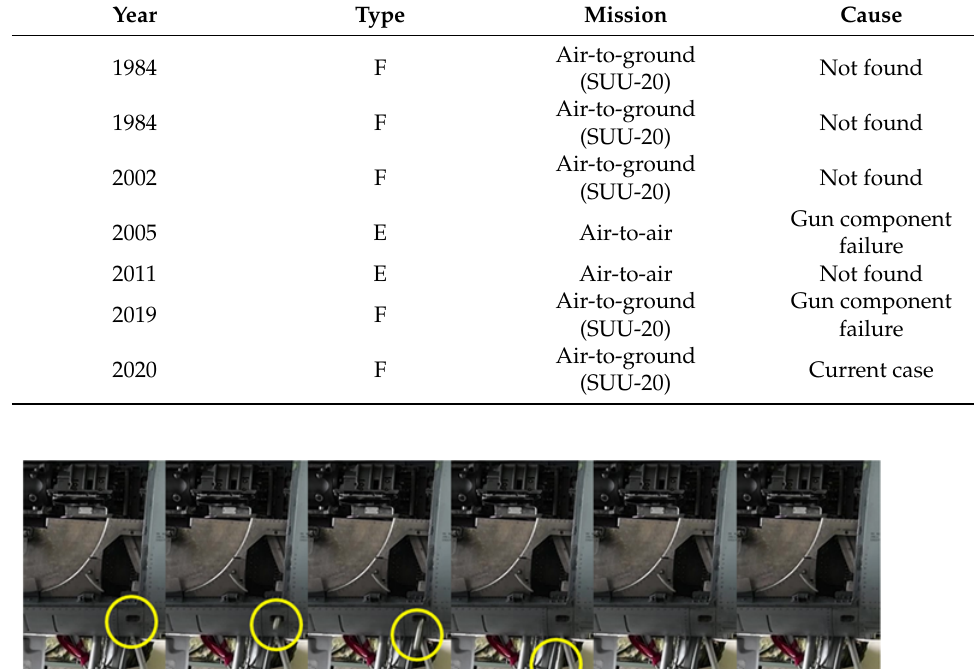
Table 1. Historical data of shell case collisions with aircrafts.